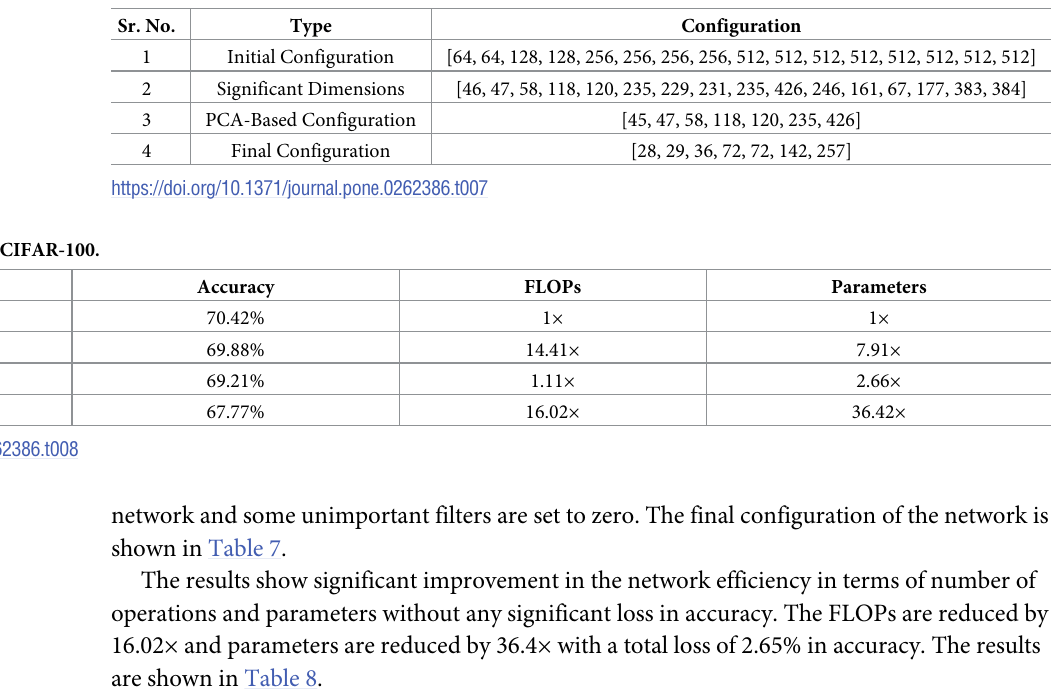
Table 7. Configuration of VGG-19 on CIFAR-100.